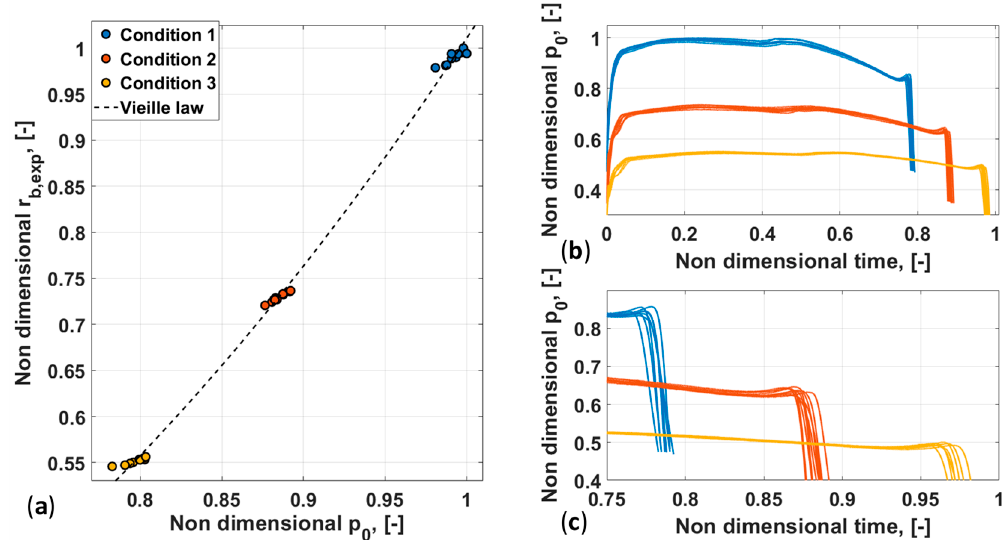
Figure 11. BARIA experimental data: ( a ) averaged values of experimental burn rate (nondimensional) vs combustion chamber pressure (nondimensional); ( b ) nondimensional chamber pressure vs time; ( c ) zoom of nondimensional chamber pressure during tail-off.